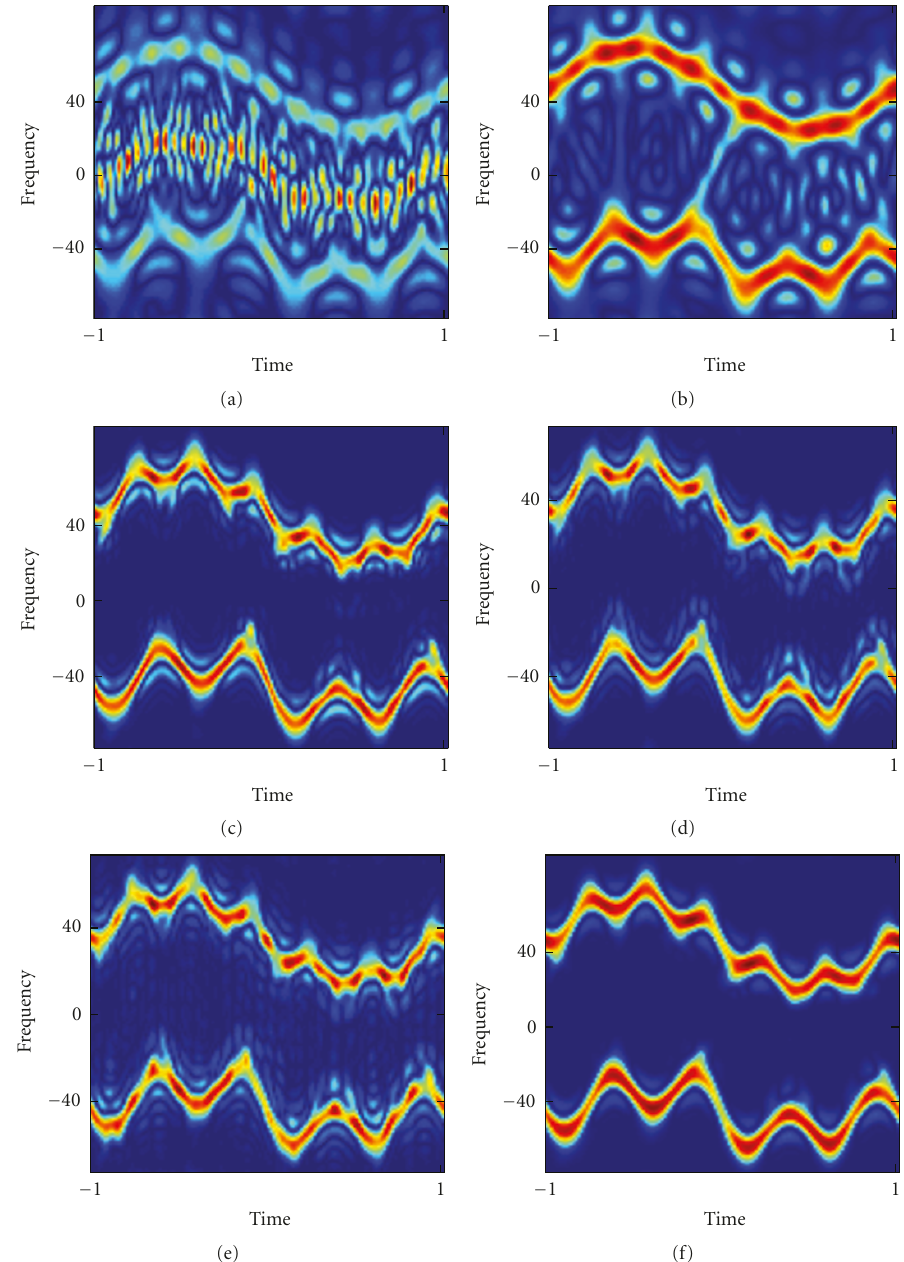
Figure 1: (a) Wigner distribution, (b) Wigner distribution with Gaussian kernel, (c) GCD AF (N = 4) with Choi-Williams kernel, (d) GCD AF (N = 4) with Born-Jordan kernel, (e) GCD AF (N = 4) with Sinc kernel, and (f) GCD AF (N = 4) with Gaussian kernel.